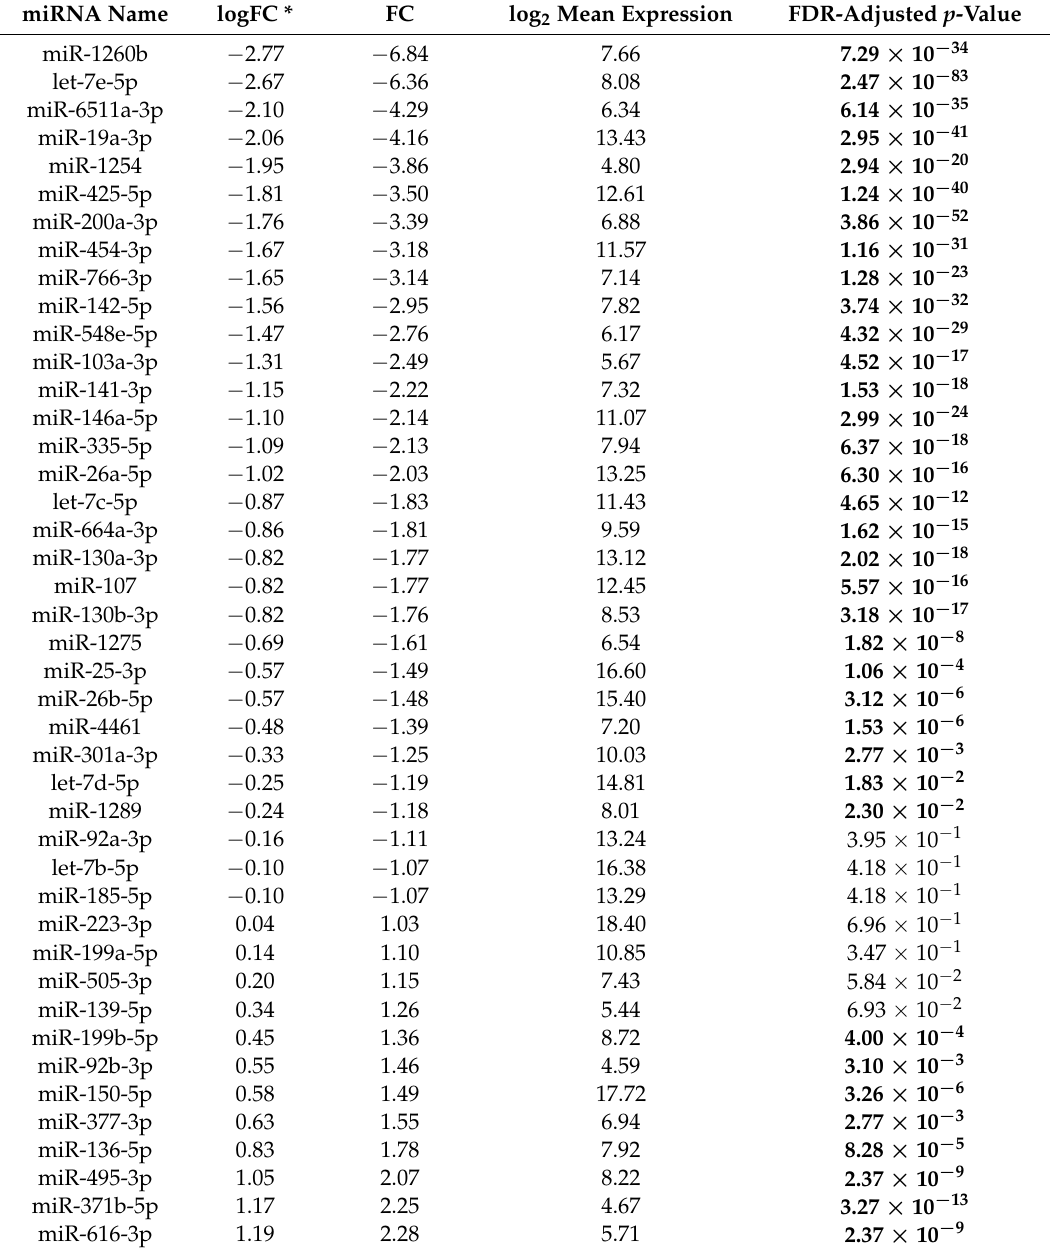
Table 4. Differential expression analysis of miRNAs in newborns compared to 7-year-old